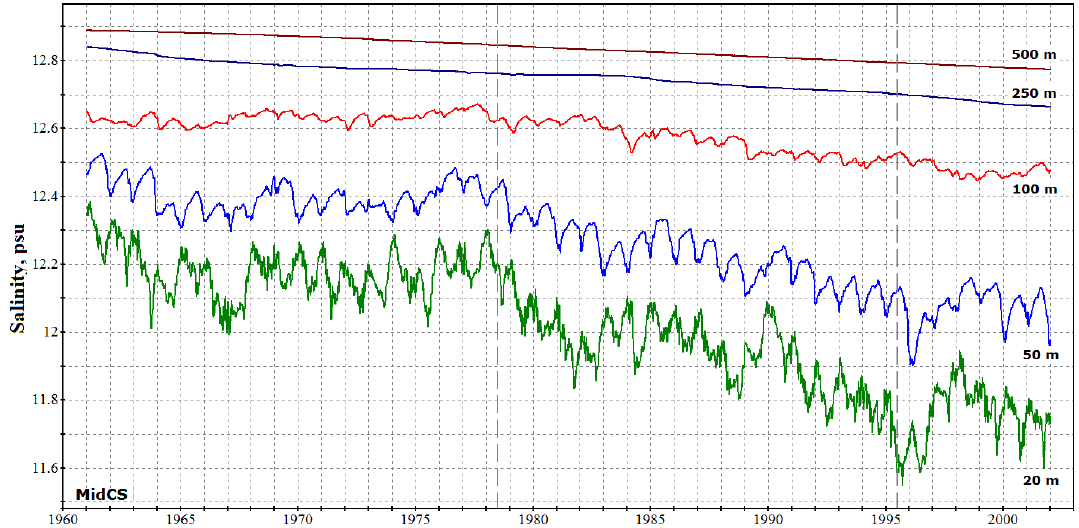
Figure 9. Evolution of salinity (psu) at different depths averaged over the MidCS basin.